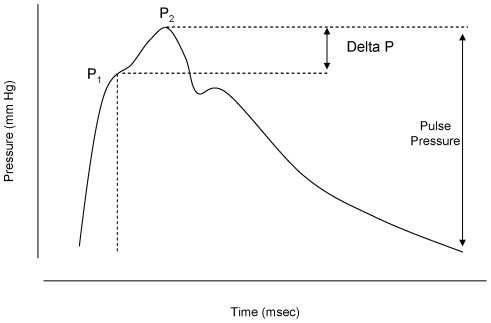
Typical ascending aortic waveform.Typical ascending waveform, showing two systolic peaks (P1 and P2). Augmentation index is calculated as the difference between P2 and P1, expressed as percentage of pulse pressure.